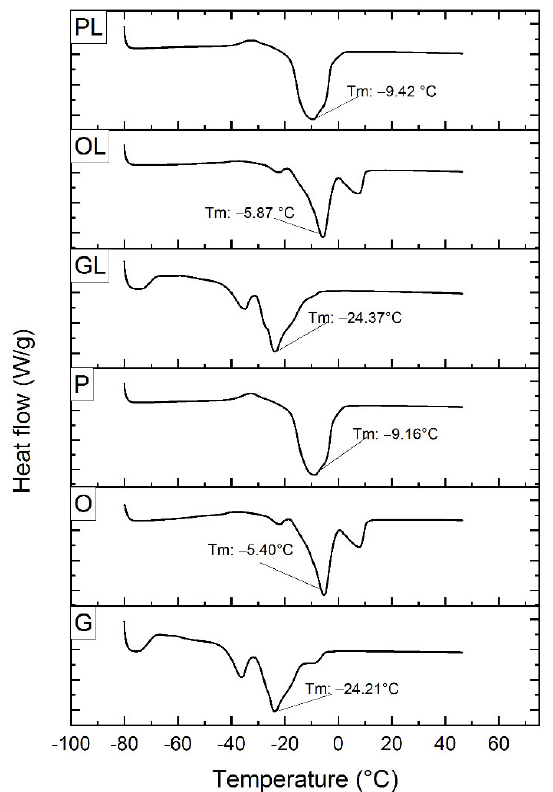
Figure 9. Determination of thermal properties in samples O, P, G, OL, PL, and GL, treated under ultrasonic conditions.